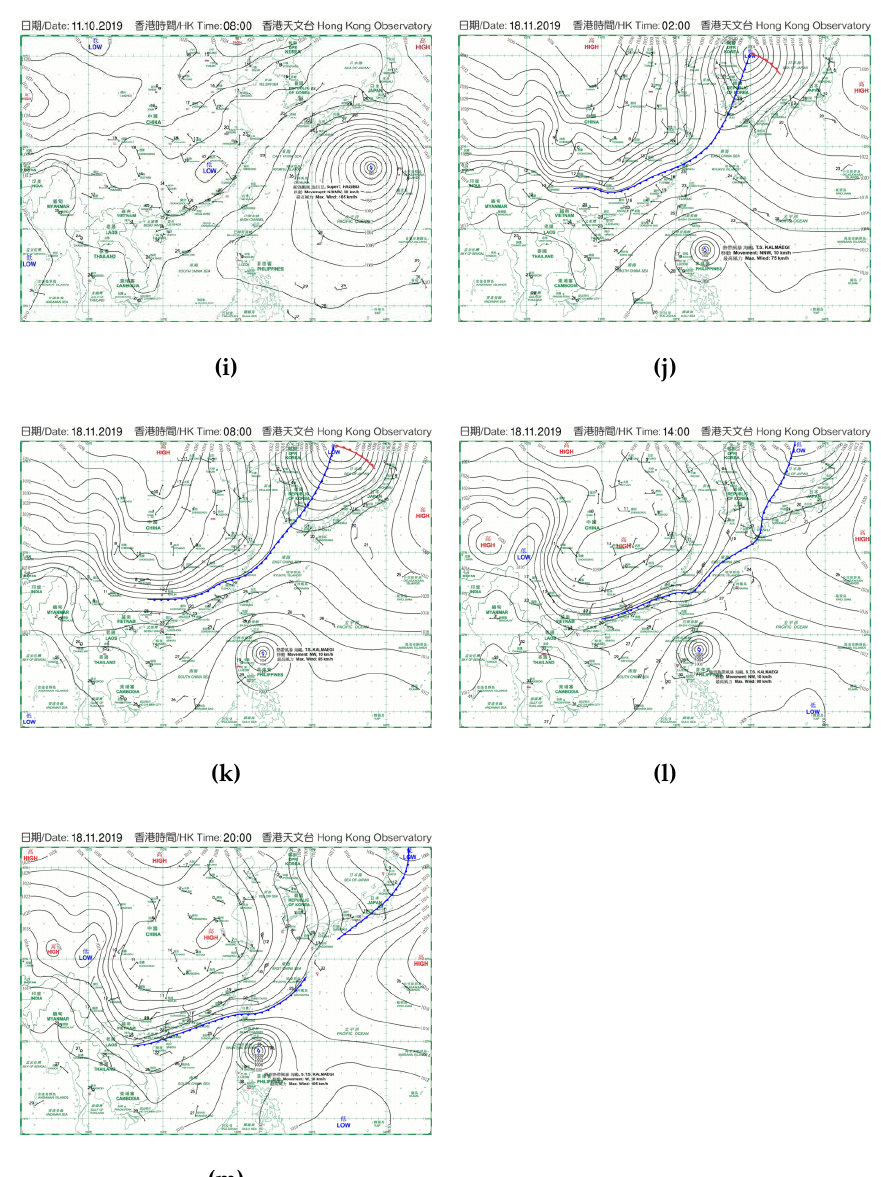
Figure 11. The weather charts (08:00 HKT) of each HPE ( a – i ) and of a cold front case occurred on 18 Nov, 2019: (j) 02:00 HKT; (k) 08:00 HKT; (l) 14:00 HKT and (m) 20:00 HKT. The weather charts were obtained from the Hong Kong Observatory web site (https://www.hko.gov.hk/en/wxinfo/currwx/wxcht.htm) on 2 Mar, 2020.